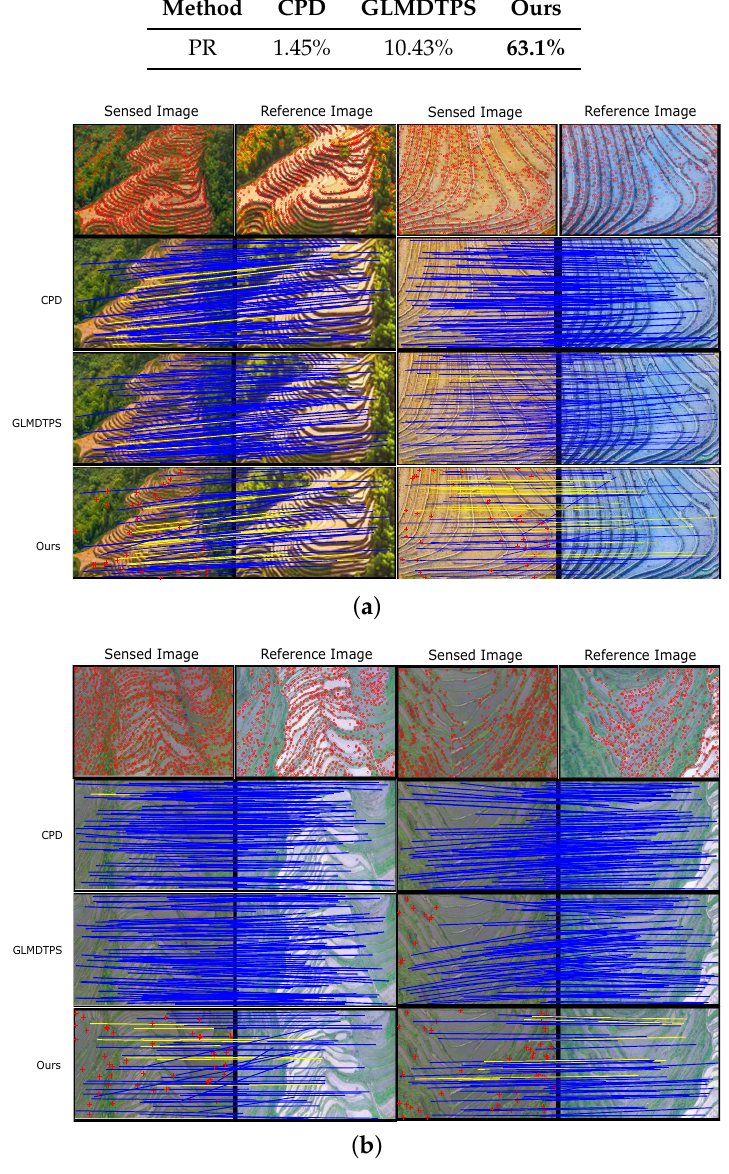
Figure 7. Feature matching demonstrations on four typical agricultural terrace image pairs. In ( a , b ), the first to the fourth rows are: the image pairs, the results on feature matching of CPD (coherent point drift), GLMDTPS (global and local mixture distance with thin plate spline transformation), and ours, respectively. Red circles denote feature points extracted by our method. Blue lines indicate the false positive and the false negative, yellow lines indicate the true positive, and red crosses indicate the true